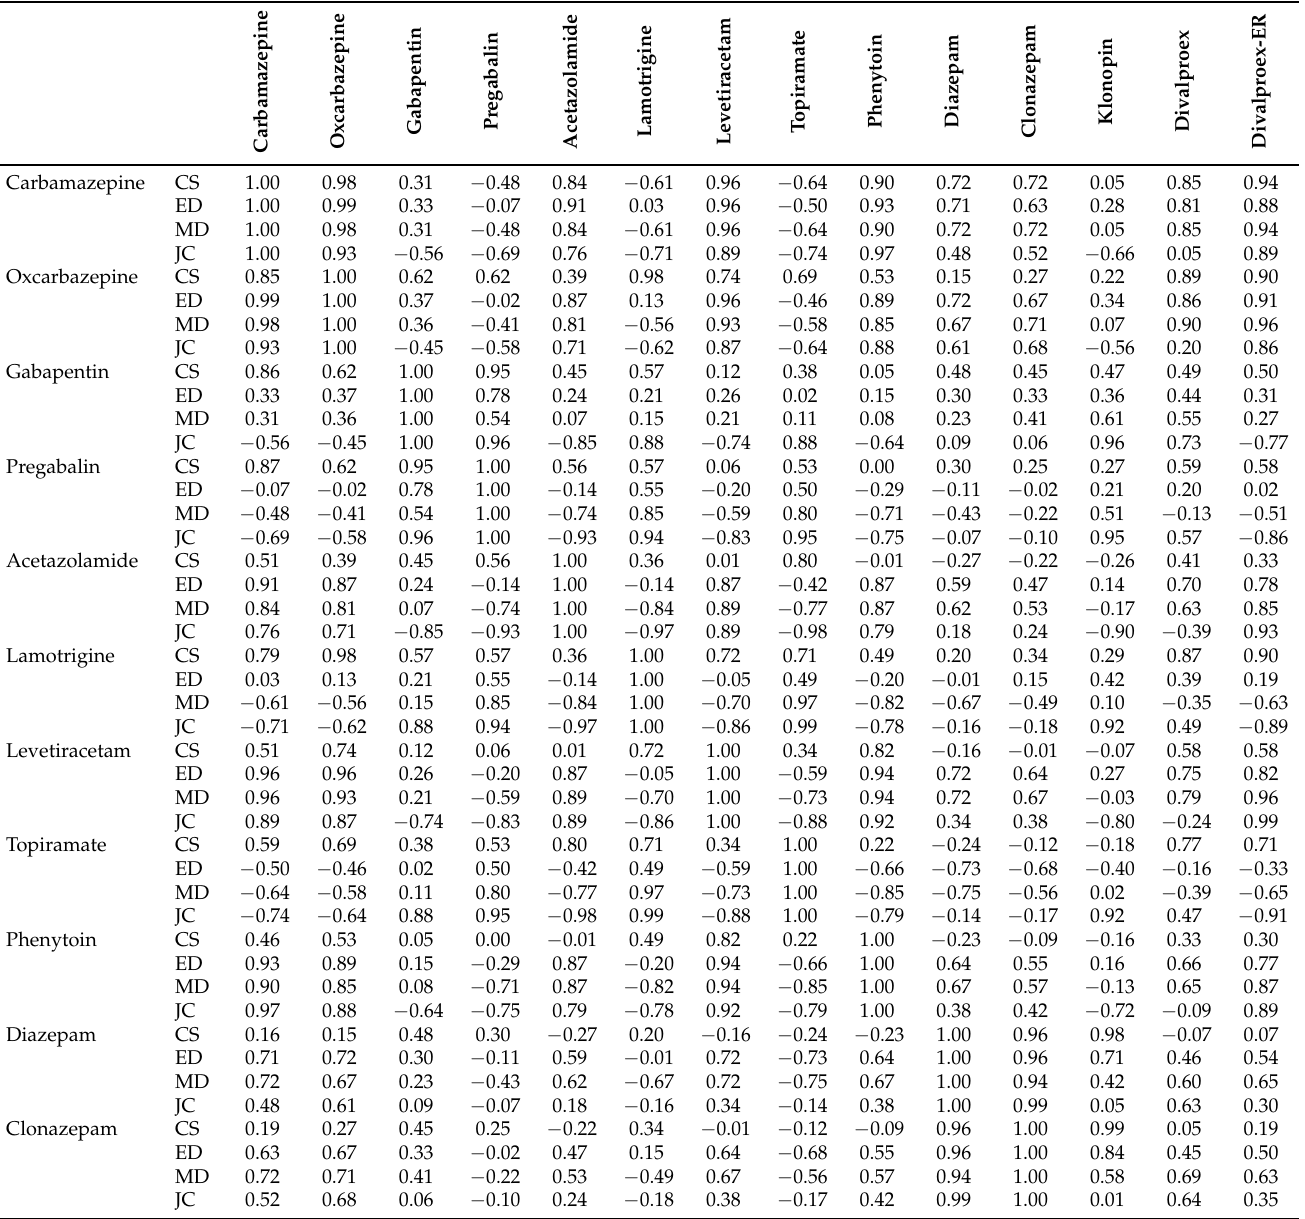
Table 10. AEDs Drug-Drug Similarity-based